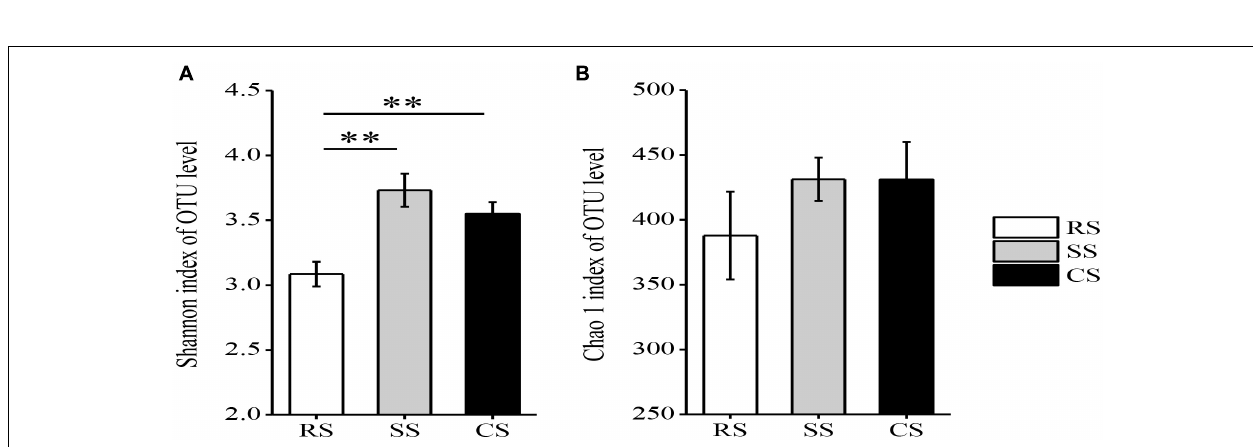
FIGURE 2 | Relative abundance of different fungi at the phylum level (A) and heat map analysis (B) of the dominant fungal genera with relative abundance greater than 0.5% in three soybean cropping systems. The color code indicated relative abundance, ranging from white (low abundance) to blue (high abundance). RS, SS, and CS represented soybean rotation with a 3-year cycle of wheat, maize and soybean, short-term continuous soybean cropping with 1-year wheat and 2-year soybean, and long-term continuous soybean cropping, respectively.